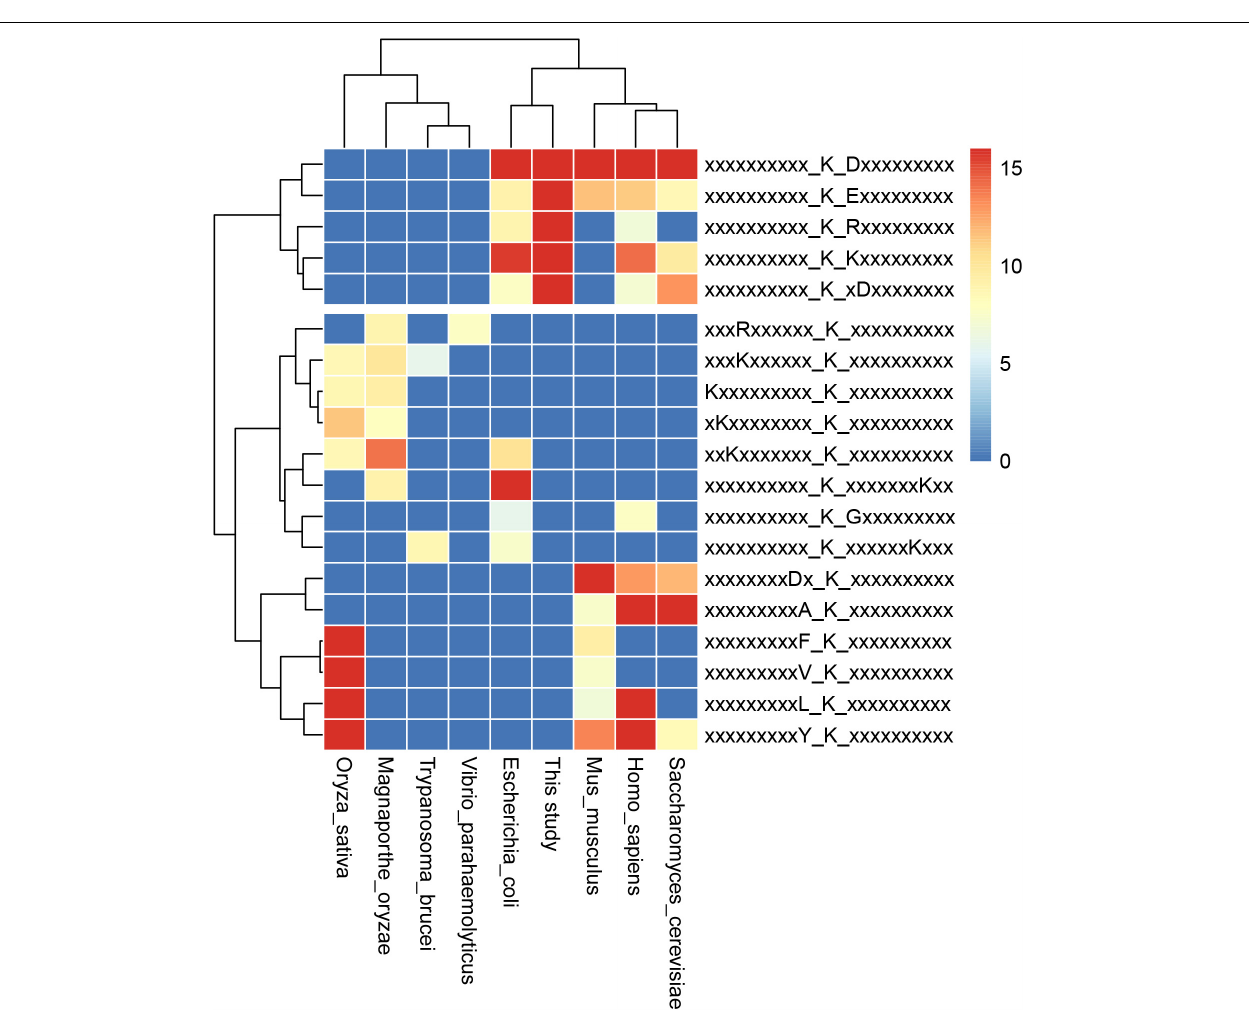
FIGURE 7 | Conservation analysis of identified motifs in the 9